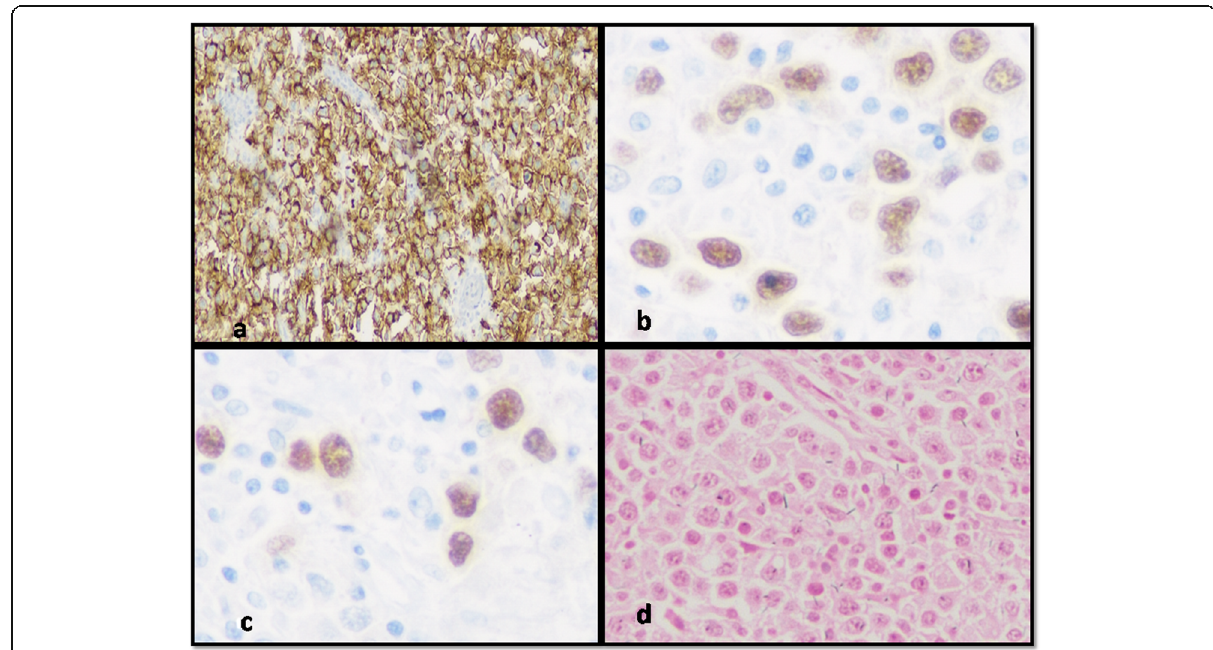
Fig. 2 Immunohistochemistry for B cell markers. a The tumor cells show strong and diffuse membranous staining for CD 20. b , c Nuclear positivity for PAX5 and OCT2 respectively in the polylobated cells. d EBER by ISH is negative